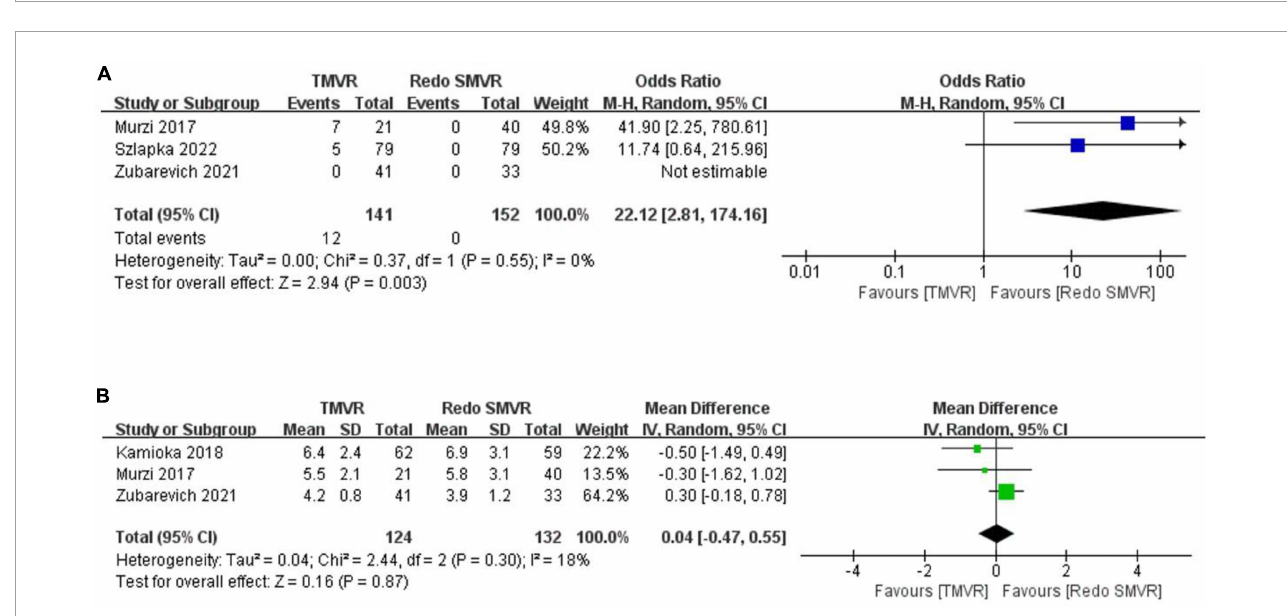
FIGURE4 Forest plot comparing TMVR with redo SMVR for (A) paravalvular leak and (B) mean mitral valve gradient. CI, confidence interval; df, degrees of freedom; MH, Mantel–Haenszel; IV, inverse variance.